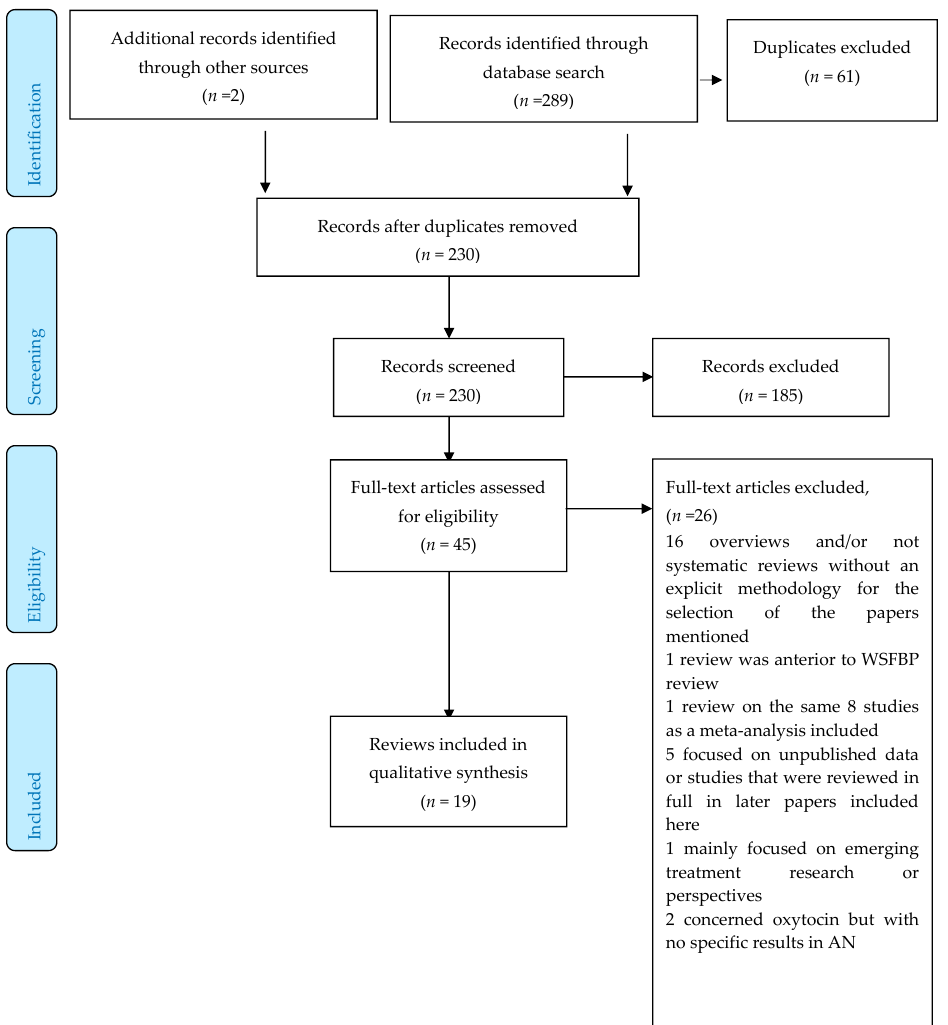
Figure 1. Preferred Reporting Items for Systematic Reviews and Meta-Analyses (PRISMA) Flow Diagram